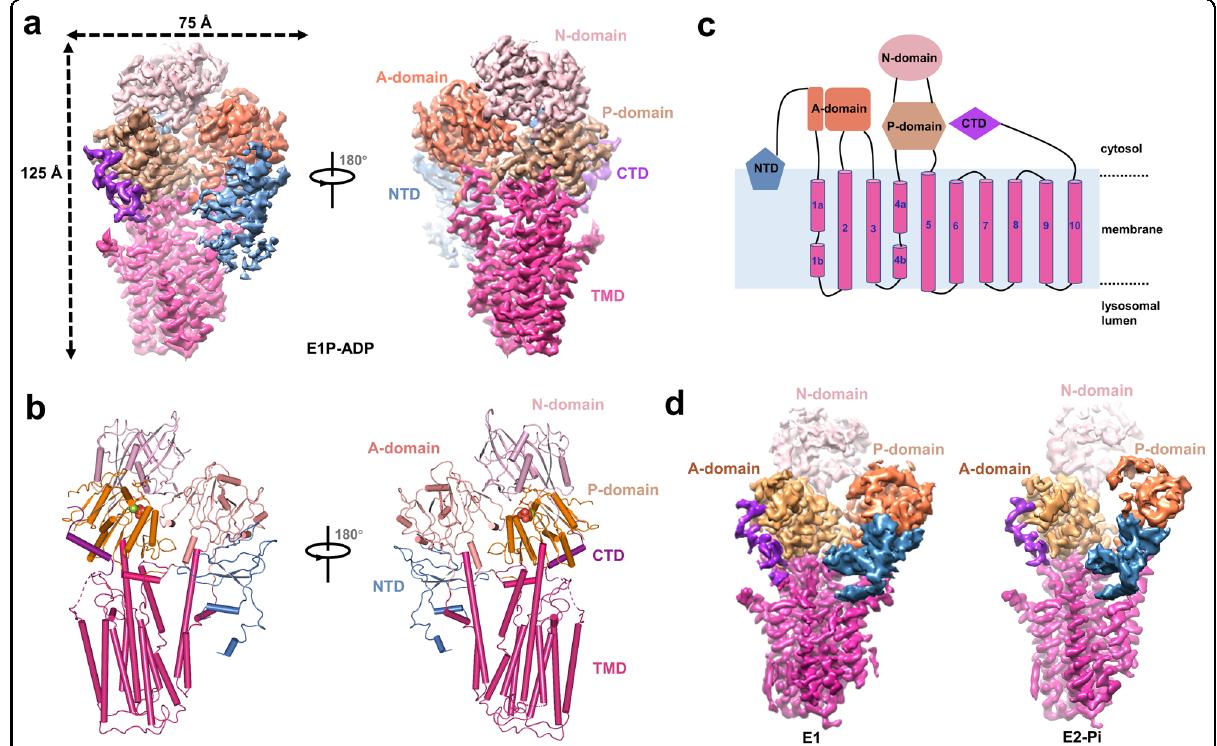
Fig. 1 Overall structure of human ATP13A2. a , b 3.0-Å-resolution cryo-EM map ( a ) and ribbon model ( b ) of human ATP13A2 in E1P-ADP state. The A, N, and P domains and the transmembrane domain are colored orange, rose, brown, and magenta, respectively. The N-terminus domain and C-terminus extension domain of ATP13A2 are blue and purple. The same color scheme is used throughout this manuscript. The ADP and Pi are shown as spheres. c Topology diagram of human ATP13A2. Conserved domains and TM helices are schematically illustrated. Note that the helix of TM4 is unraveled halfway by a P5B-ATPase conserved PP(A/V)LP motif. d Cryo-EM maps of human ATP13A2 in E1 state and E2-Pi